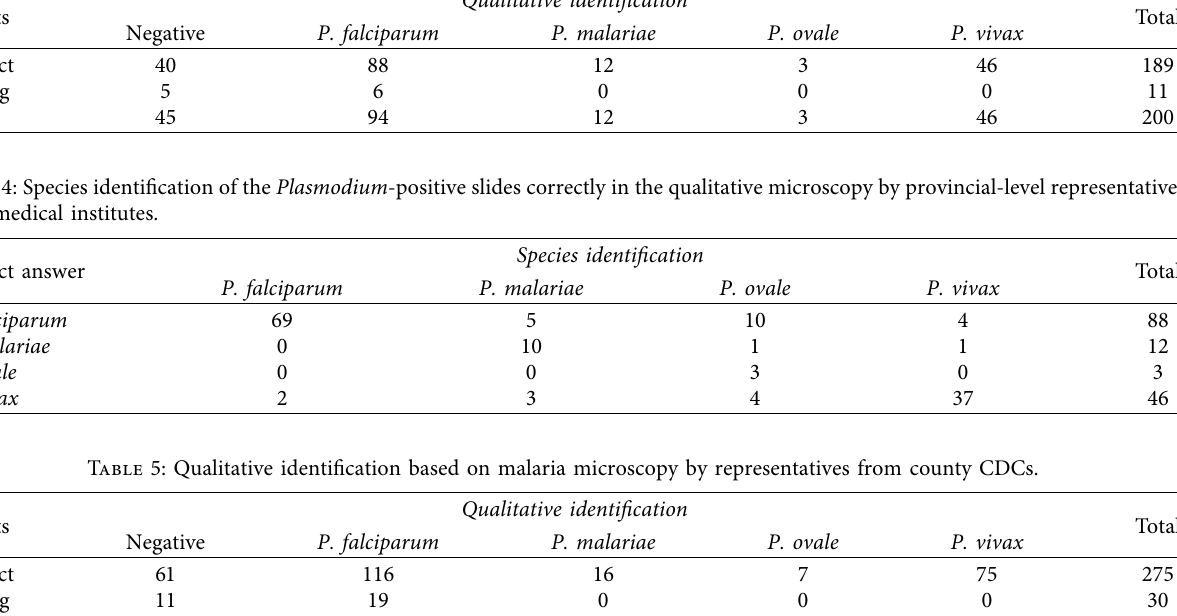
Table 3: Qualitative identification based on malaria microscopy by provincial-level representatives from medical institutes. Results